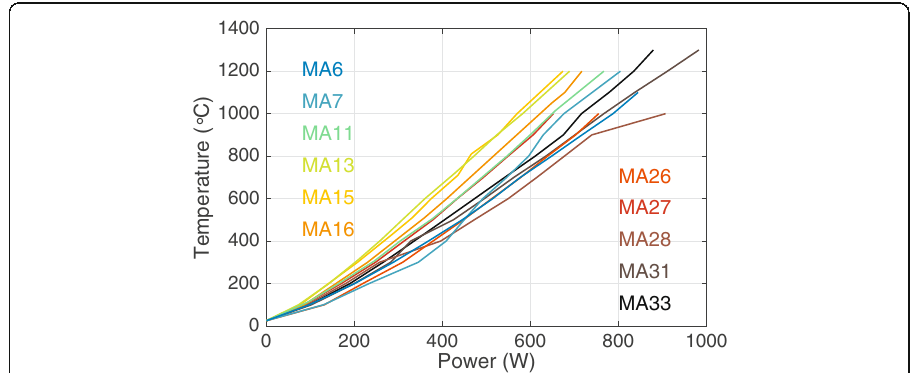
Fig. 9 The relation between electrical power and thermocouple temperature as recorded for the experiments in this study (Table 1). Power and temperature are recorded at every subsequent 100 degree interval and linearly